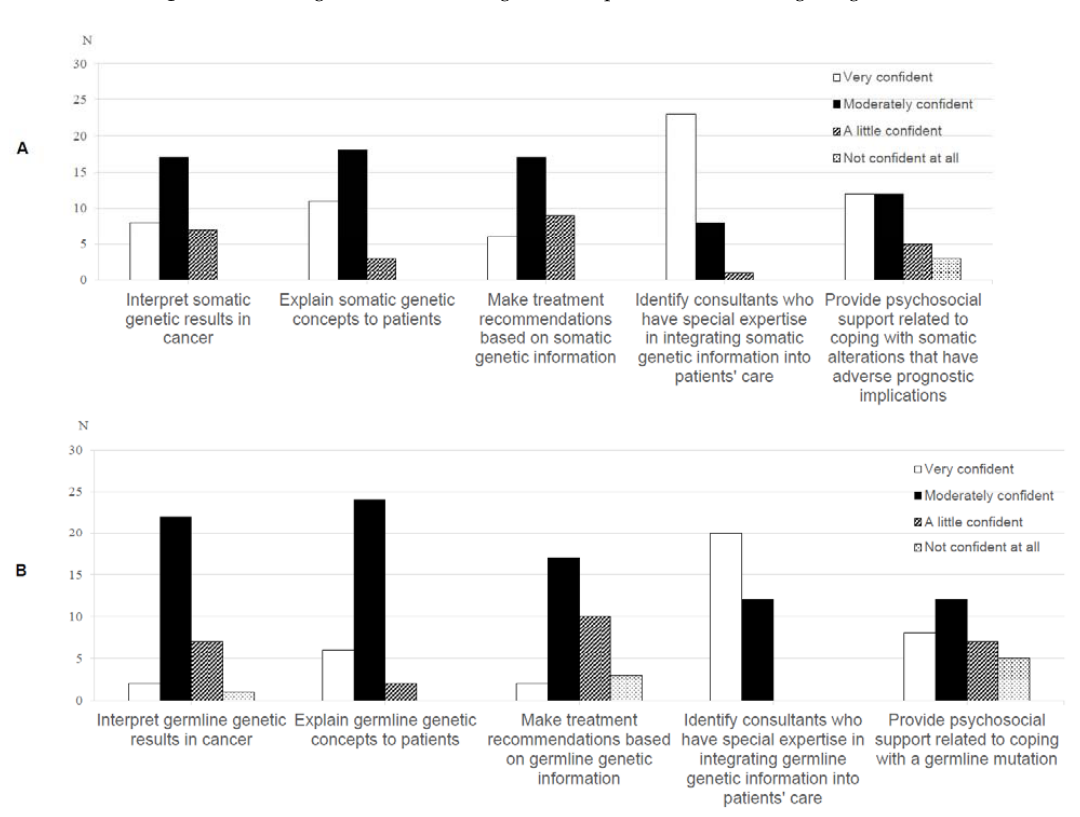
Figure 3. Oncologists’ ( n = 35) ratings of their confidence with ( A ) somatic and ( B ) germline genetic test results.